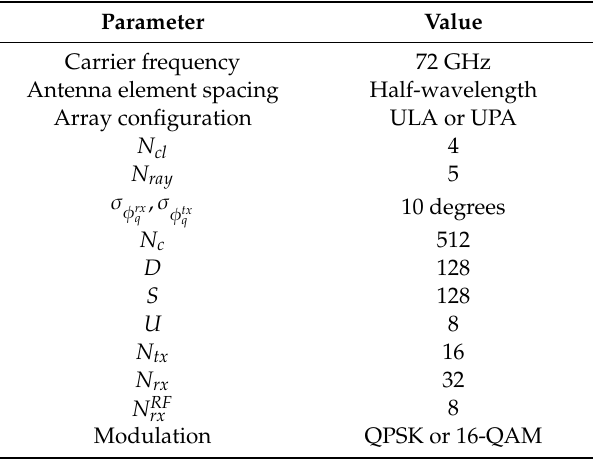
Table 1. Simulation